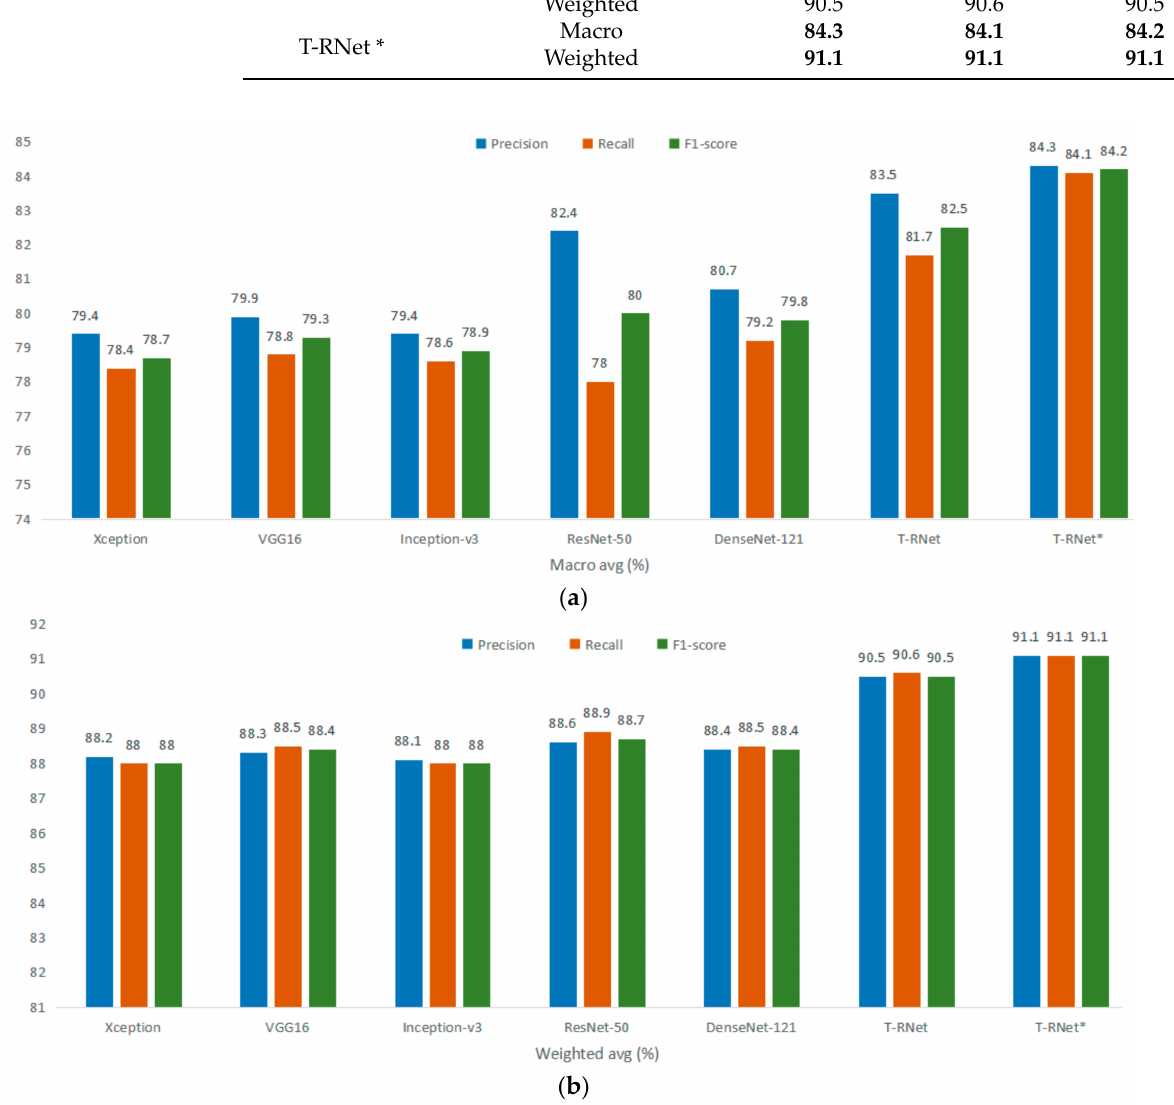
Figure 7. ( a ) Performances of different classification methods in terms of precision (%), recall(%), and F1-score (%) by Macro averages. ( b ) Performances of different classification methods in terms of precision (%), recall (%), and F1-score (%) by Weighted averages.(T-RNet * indicates the combination of T-RNet and FAMP-Softmax